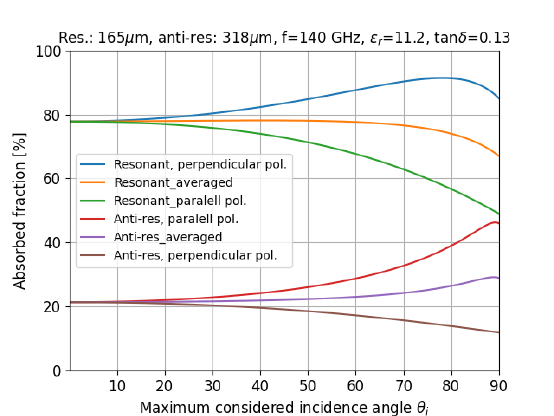
Figure 8. Modelled isotropic stray radiation response with input data from Fig. 7. Upper traces: resonant, 165 µ m, lower traces: anti-resonant, 318 µ m. The absorbed fractions are plotted as a function of considered range of incident angles, e.g. θ i = 0 ◦ is normal incidence while θ i = 20 ◦ includes all incidence angles up to 20 ◦ . For each thickness the response to perpendicular and parallel polarisation is plotted. The averages of these (label ’av- eraged’) is the overall isotropic stray radiation